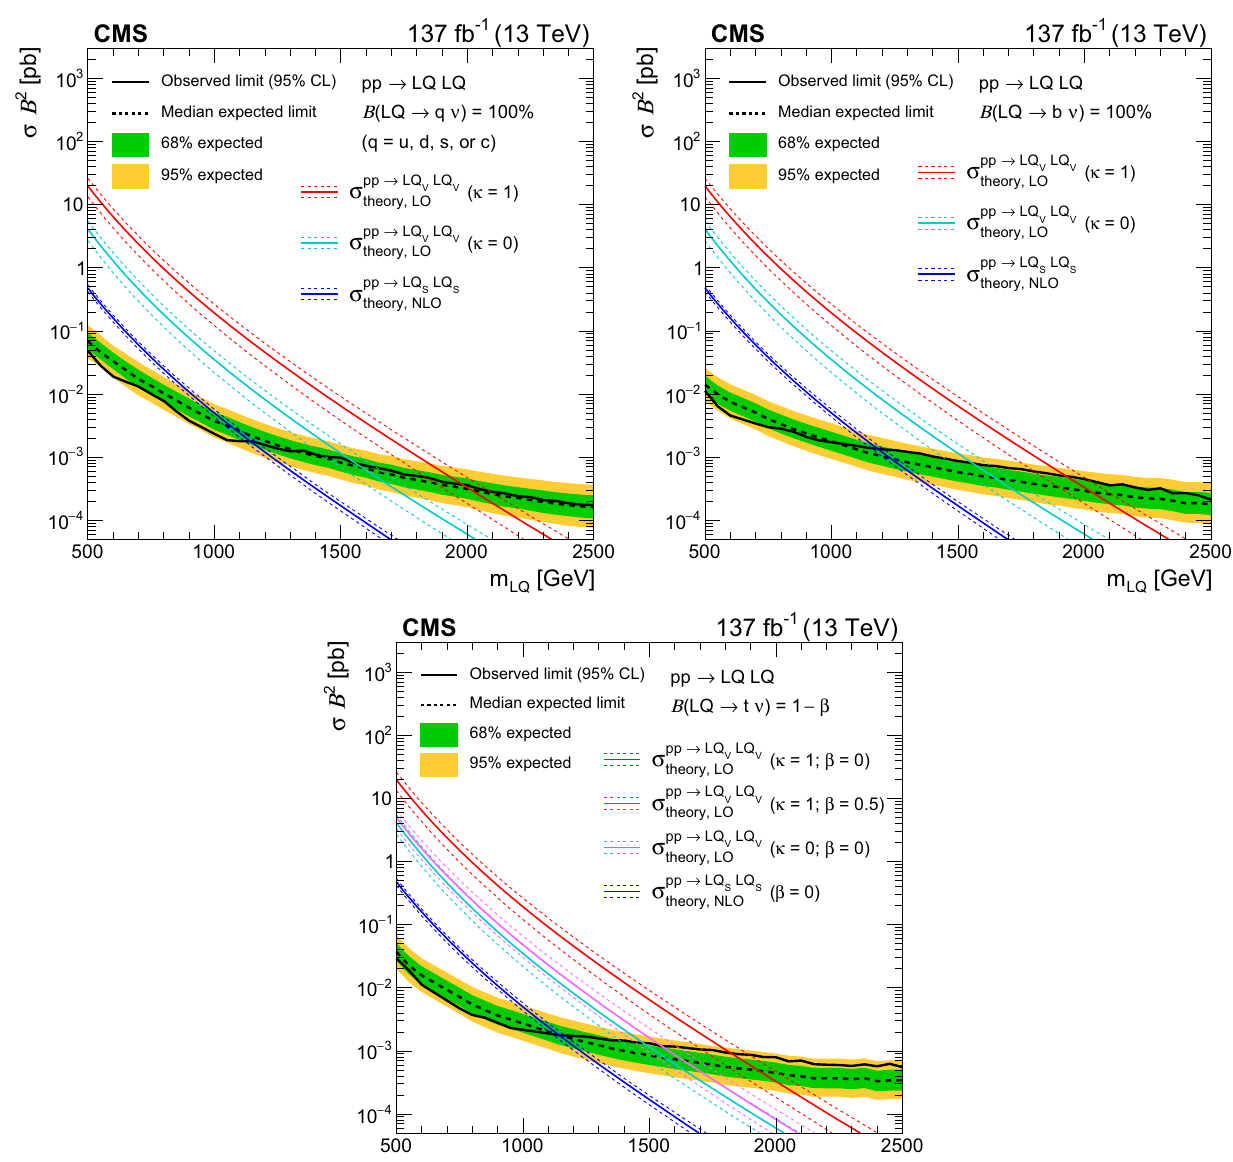
Fig. 16 The 95% CL upper limits on the production cross sections as a function of LQ mass for LQ pair production decaying with 100% branchingfraction( B )toaneutrinoand(upperleft)alightquark(oneof u, d, s, or c), (upper right) a bottom quark, or (lower) a top quark. The solid (dashed) black line represents the observed (median expected) exclusion. The inner green (outer yellow) band indicates the region containing 68 (95)% of the distribution of limits expected under the background-only hypothesis. The dark blue lines show the theoretical